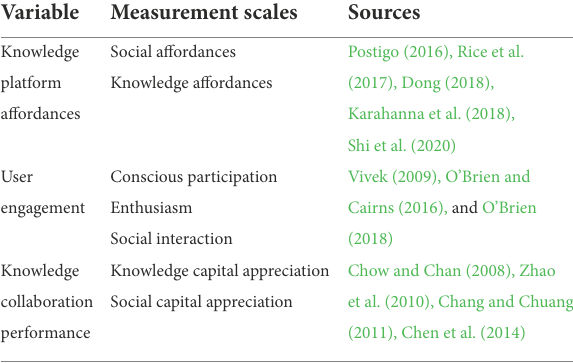
TABLE 2 Main measurement scales in the research